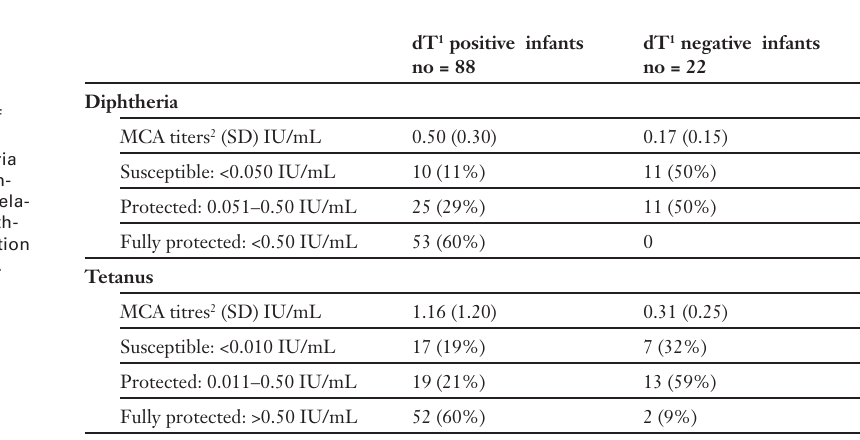
Table 3 Immunogenicity 1 of diphtheria and tetanus components of combined diph- theria-tetanus and pertussis vaccine (DTP) after adminis- tration of three doses of DTP vaccine and its relation to mater- nal passive immunity in 69